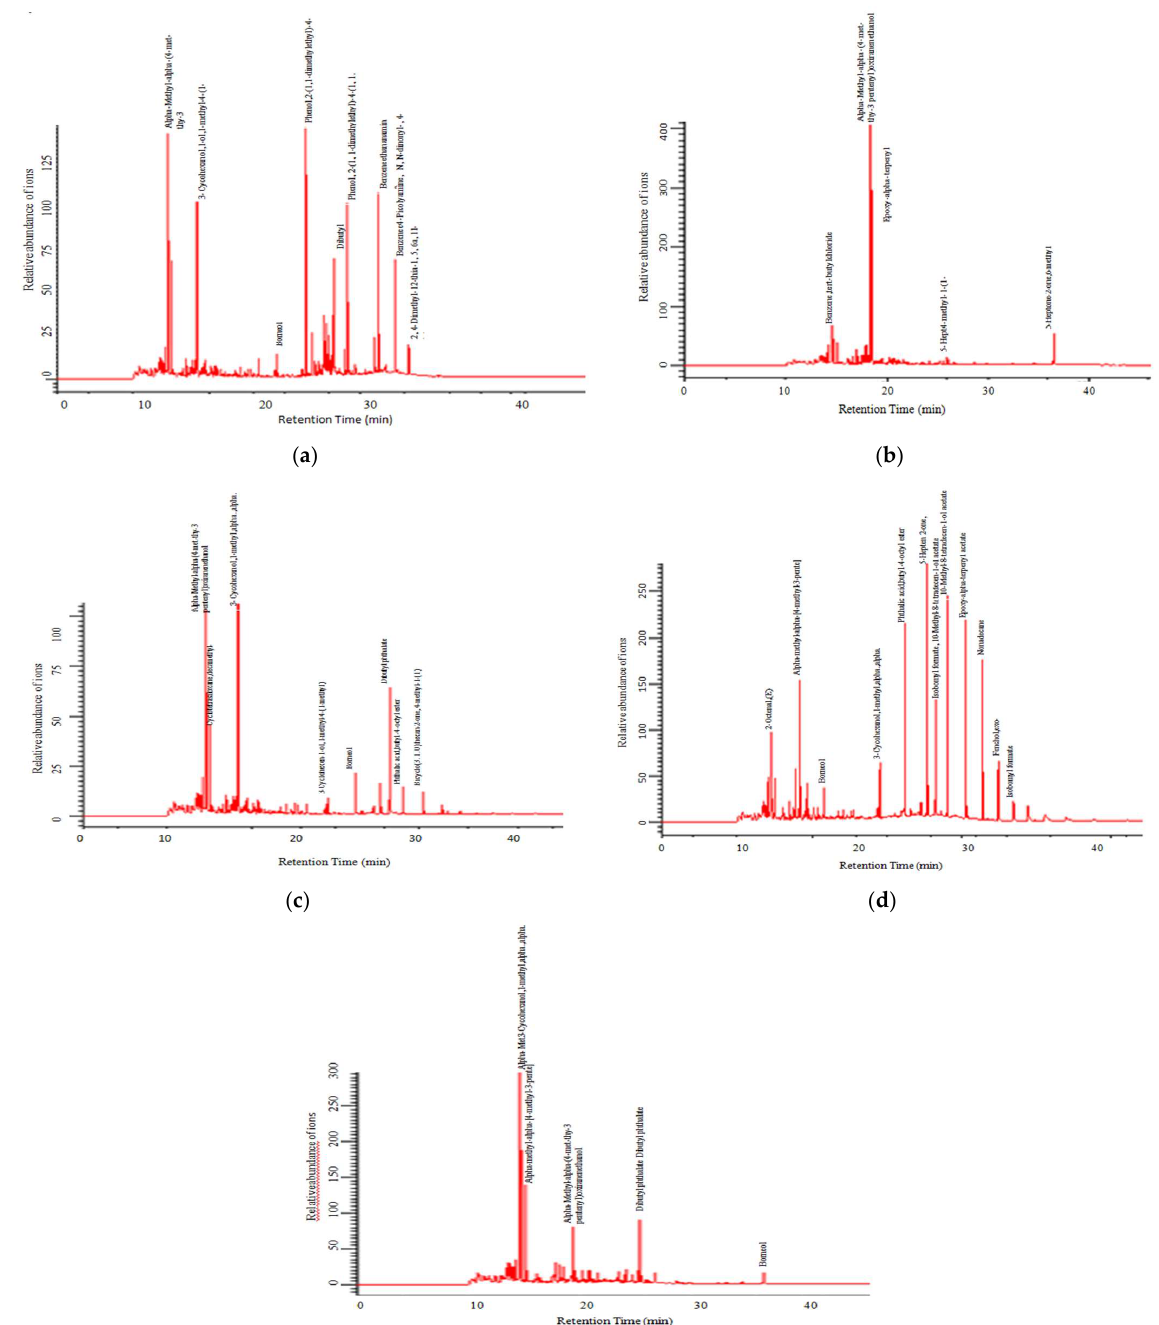
different districts of Bangladesh.